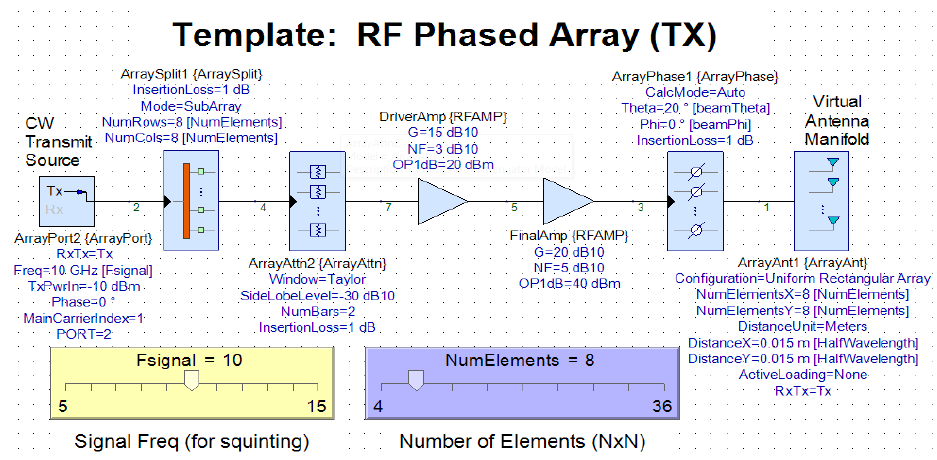
Fig. 5. An example of an antenna model designed in